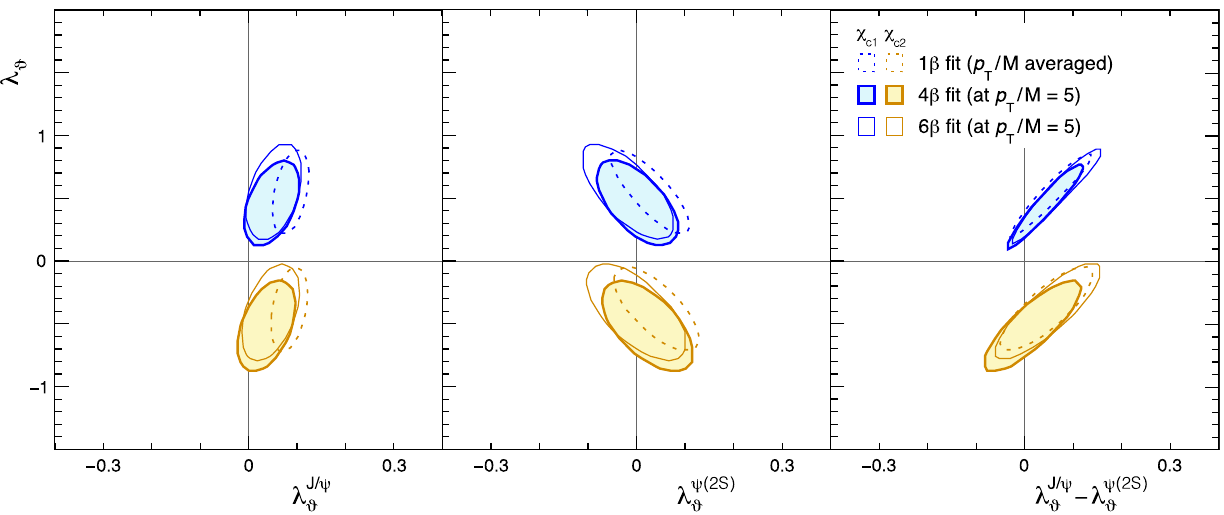
Fig. 7 Two-dimensional distributions showing the correlations between the λ down contributions to the prompt J /ψ production rate (right). The results of the three fit variants are represented by the solid (4 β ), dashed (1 β ) and dotted-dashed (6 β ) lines